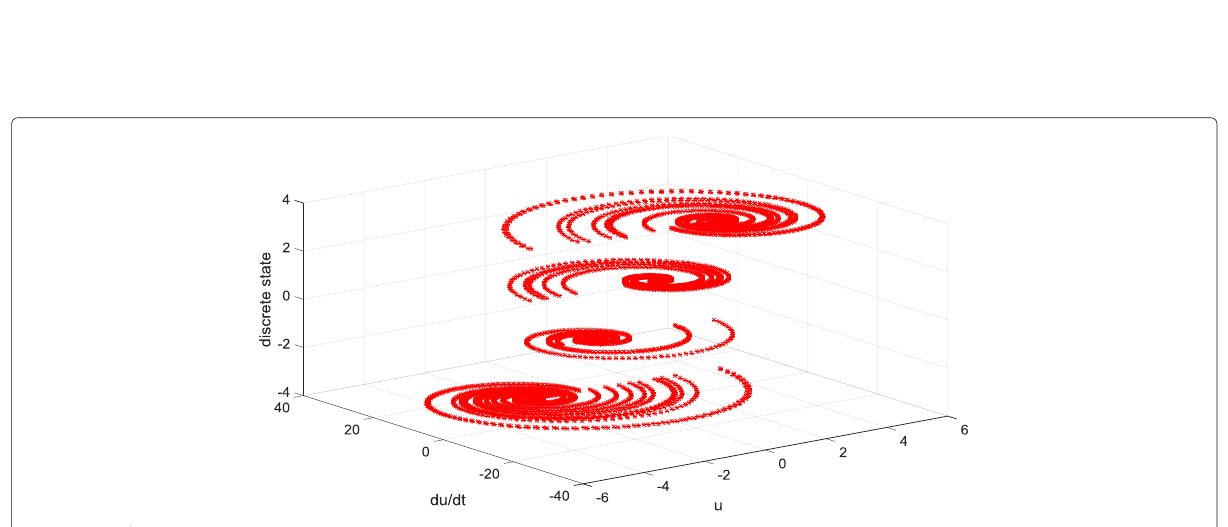
Fig. 11 3D phase-space